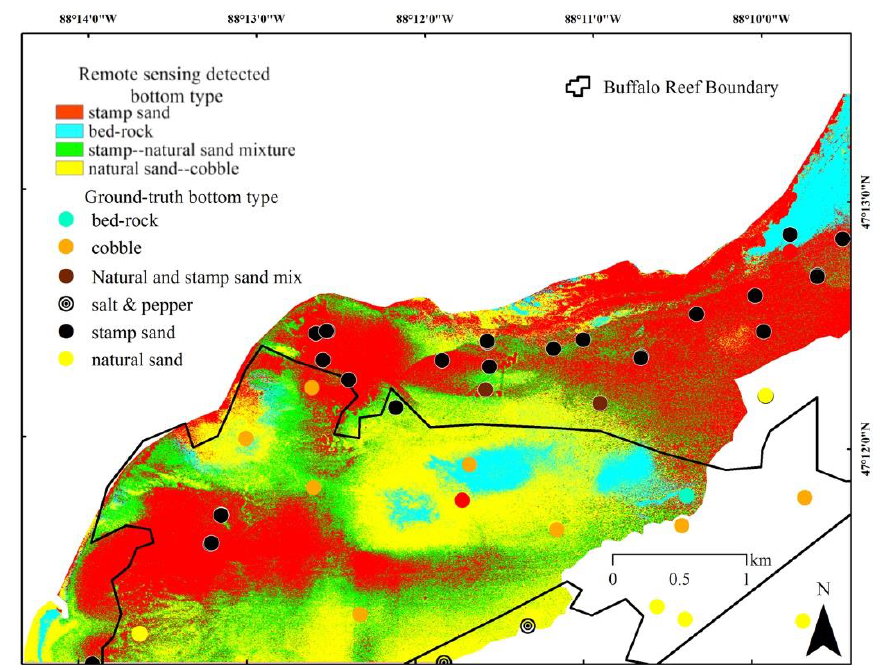
Figure 13. Three-band 2009 NAIP-derived substrate classification map, based on bottom color reflectance. Dots indicate Ponar and underwater camera ground-truth checks of substrate types. The boundaries of Buffalo Reef are superimposed upon the substrate map. Red regions are low reflectance areas where migrating stamp sands have encroached upon Buffalo Reef cobble and boulder fields and are used to calculate 25% stamp sand cover of the reef. Clear region to right lays outside of bottom reflectance.